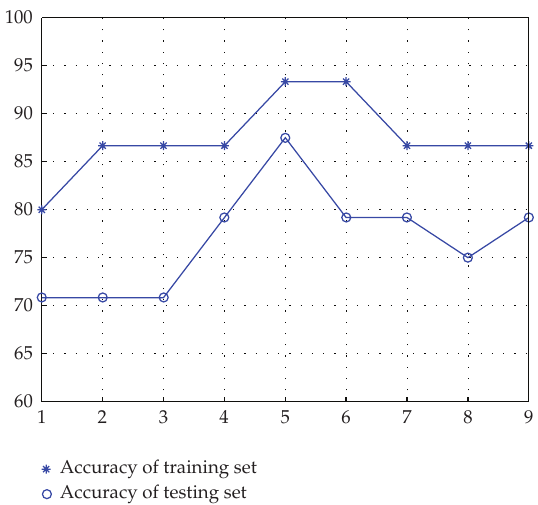
Figure 1: The results of SVMs with various C where δ 2 is fixed at